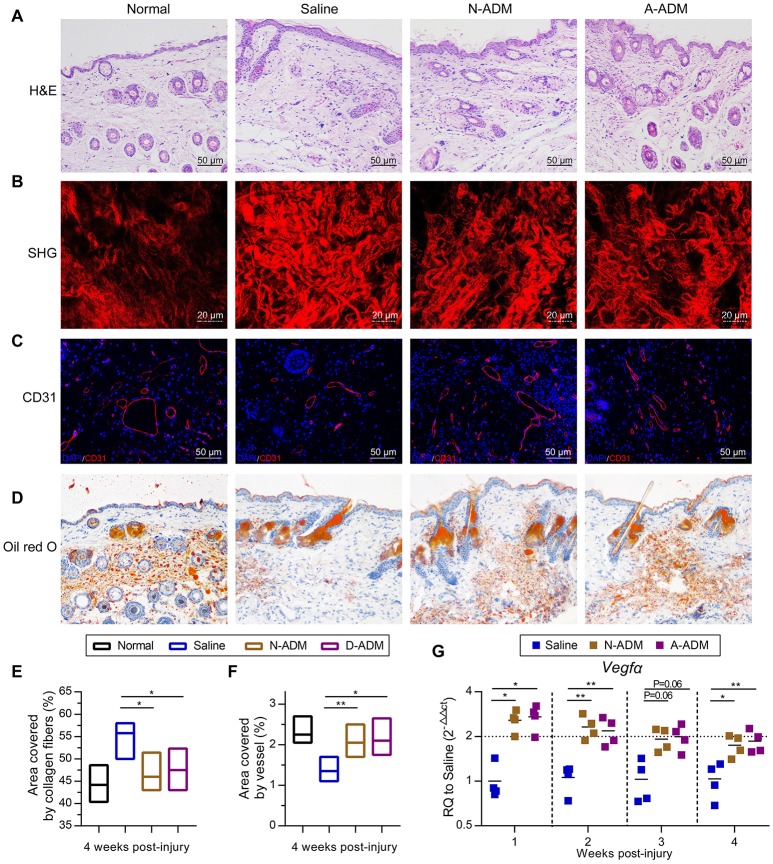
Regeneration and reconstruction of skin structures after ADM scaffold treatment. (A) Representative H&E staining of new skin tissue at 4 weeks after injury. (B) TPF/SHG scanning images of new skin tissue at 4 weeks after injury. (C) Representative micrographs showing the immunostaining of vessel area with CD31 at 4 weeks after injury. (D) Representative oil red o staining of new skin tissue at 4 weeks after injury. (E) Quantification of collagen fibers area in wound sites of four groups based on TPF/SHG scanning images (n = 5 mice from two experiments). (F) Quantification of vessel area in wound sites of four groups based on CD31 staining (n = 5 mice from two experiments). (G)
Vegfα displayed as a fold change over saline control at indicated weeks after wound treatment with N-ADM, or A-ADM (n = 5 mice from two experiments). ANOVA: *P < 0.05, **P < 0.01, ***P < 0.001.